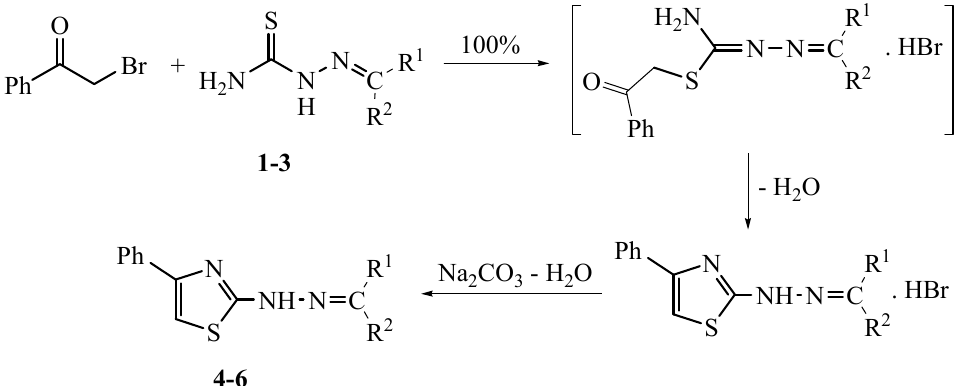
Scheme 3. The suggested solid-state mechanism for the reaction of phenacyl bromide and thiosemicarbazones 1 – 6 .